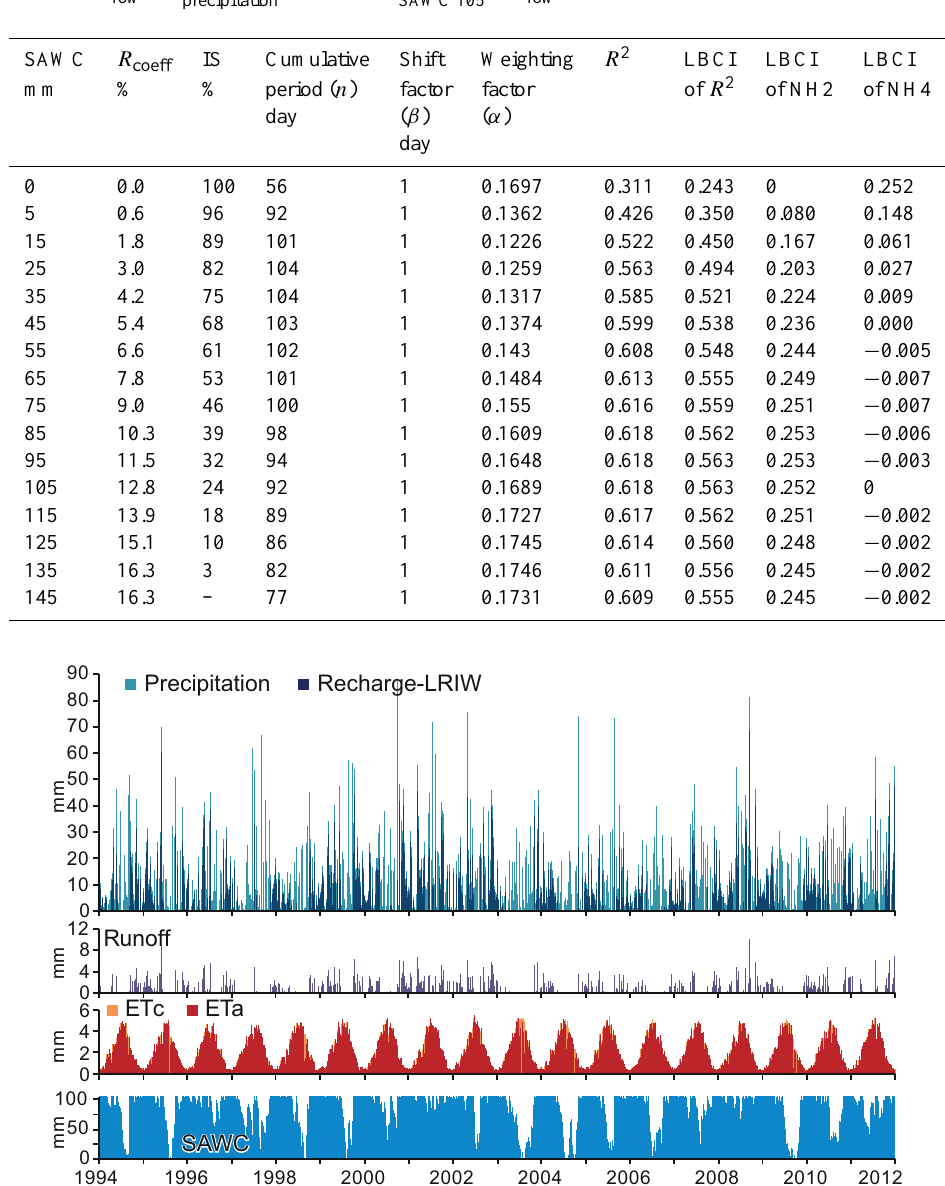
Table 5. Sensitivity analysis results of the best correlation between precipitation/ R LRIW and A16 extensometer detrended displacement. IS is for infiltration structures. SAWC is the soil available water capacity. LBCI is the lower bound of the confidence interval. R 2 row is the R 2 computed from recharge-area parameters indicated in each table row. Cumulative period ( n ), shift factor ( β ) and weighting factor ( α ) are the